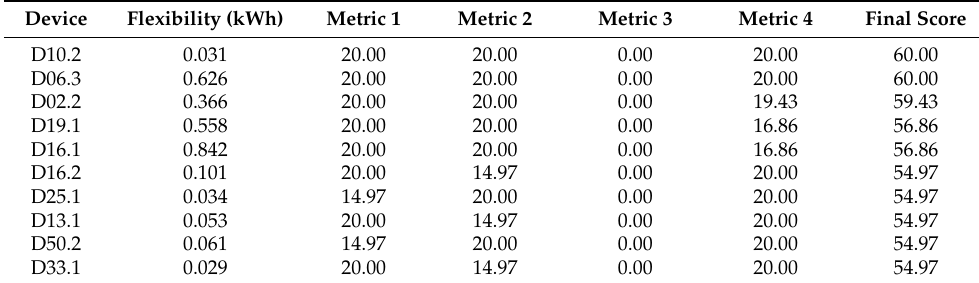
Table 2. Score of the top 10 IoT